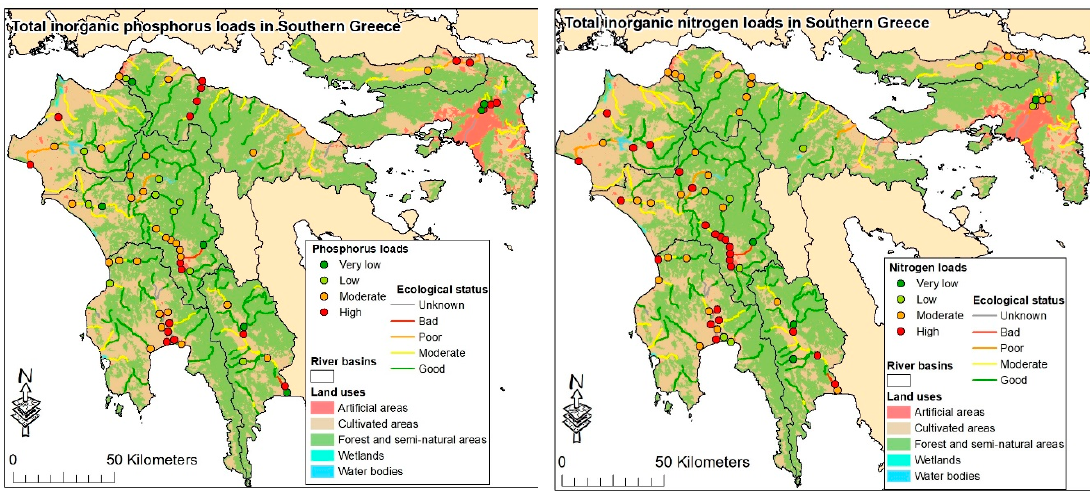
Figure 5. Maps are showing ecological classification of water bodies and classes of phosphorus loads ( left ) and total inorganic loads ( right ) in catchments of Southern Greece.